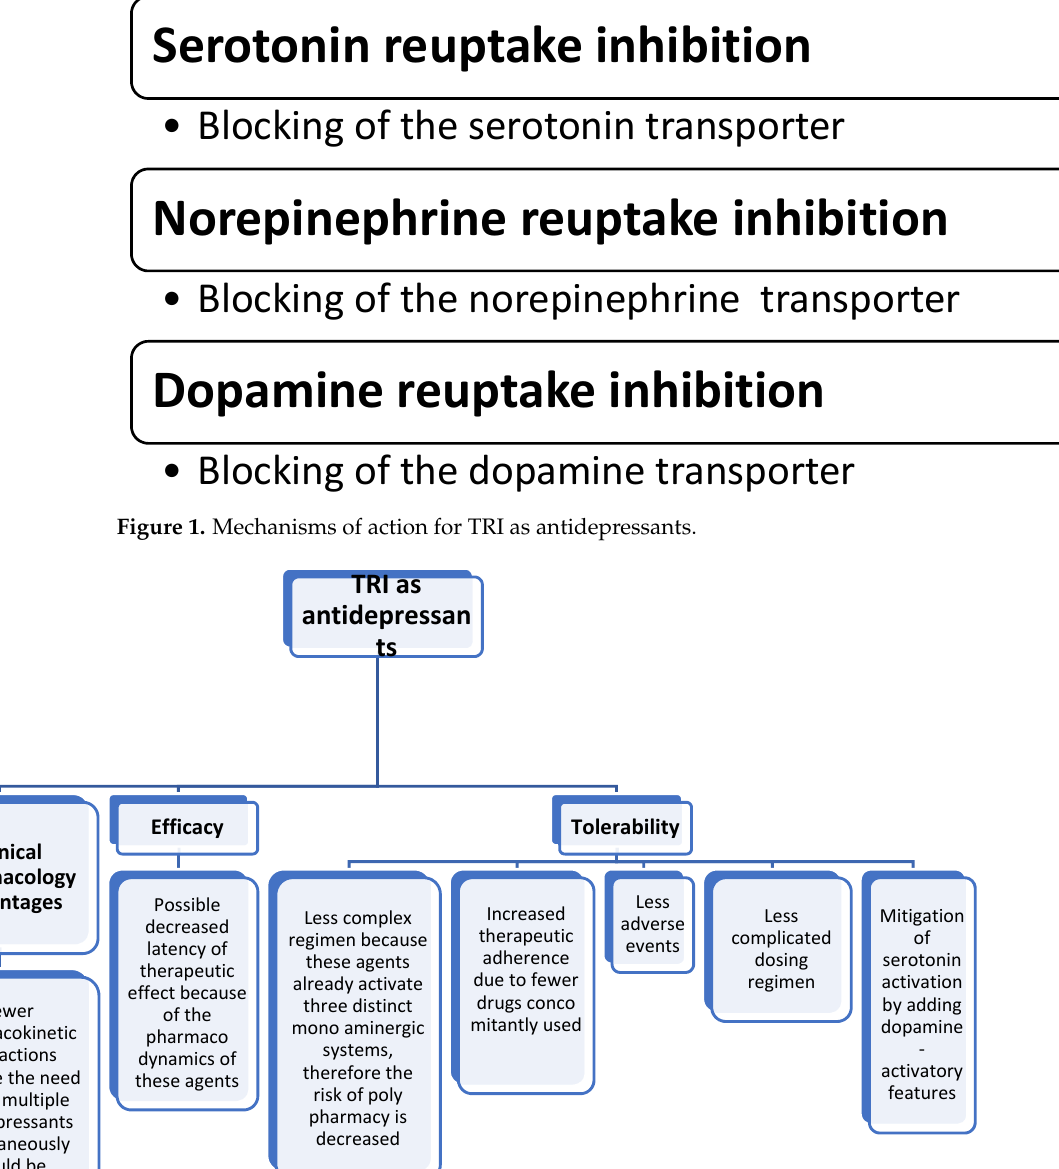
Figure 2. Potential benefits of TRI as antidepressants use in clinical